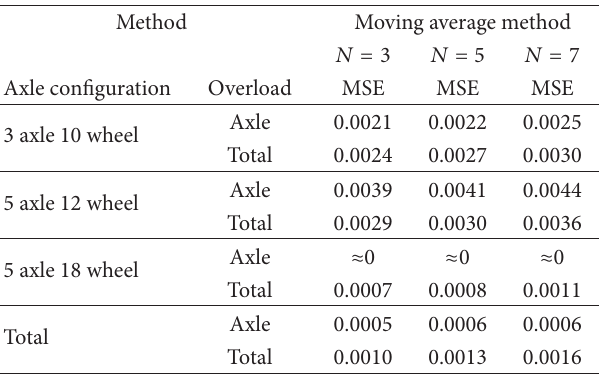
T 4: Coefficients and mean square errors in moving